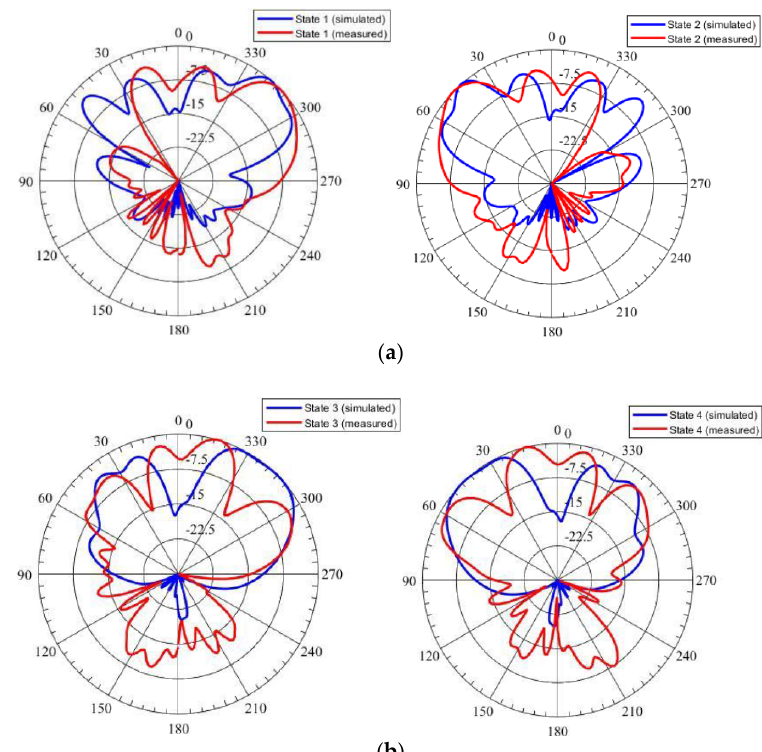
Figure 10. Far Field measurement of the fabricated prototype ( a ) Far-field setup ( b ) Strcuture Placement and Biasing.